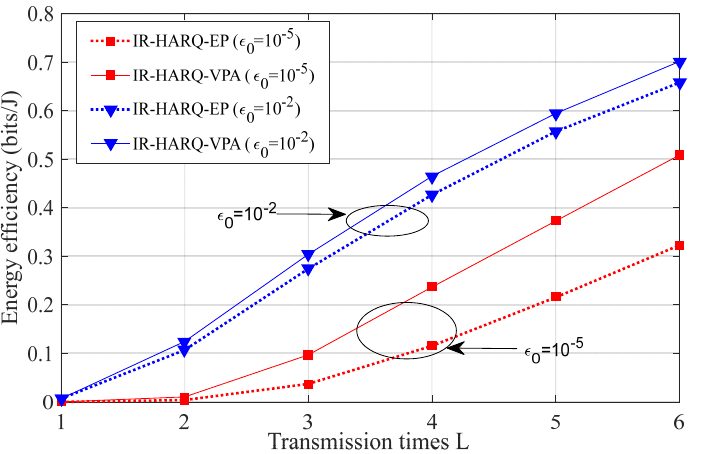
Figure 9. The energy efficiency of IR-HARQ-EP and IR-HARQ-VPA schemes under different values of L ( R = 2, K = 0 )